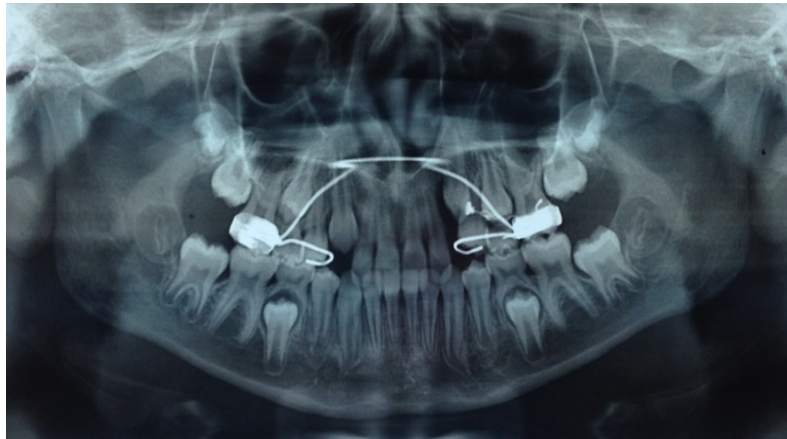
Figure A6. Post-treatment panorex of patient L.C. The distalization was obtained in 4 months.